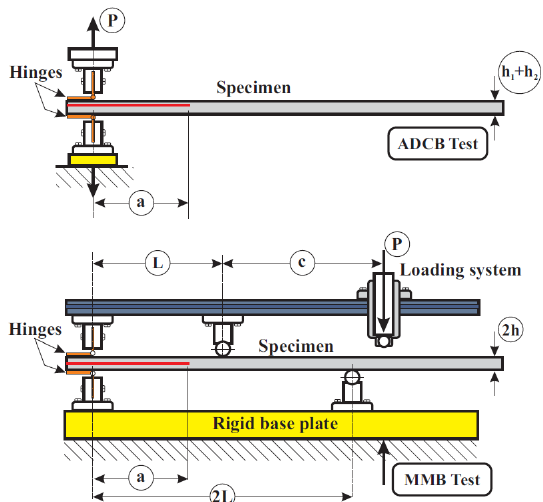
Figure 2. Scheme of the ADCB and MMB test methods employed.